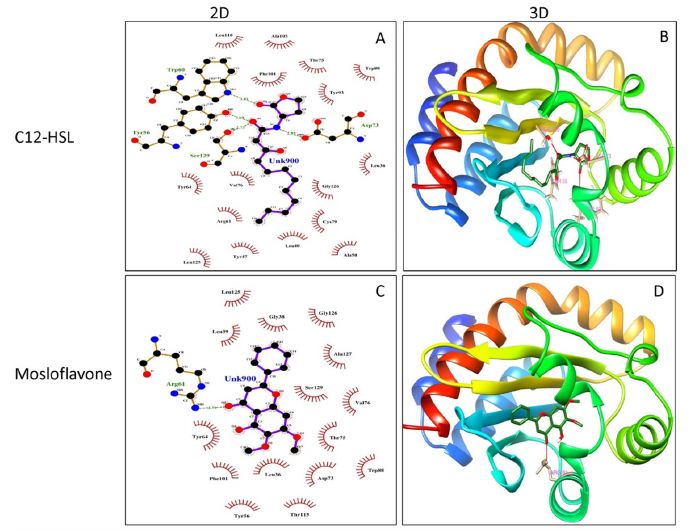
Fig. 5. Molecular docking studies of mosloflavone from crude extract of P. tenuiflorus to study the binding affinity with the active site of the receptor protein, LasR compared to the natural ligand (C12-HSL). (A) 2D docked conformation of C12-HSL (natural ligand) into the active site of LasR; (B) 3D docked conformation of C12-HSL into the active site of LasR, (C) 2D docked conformation of mosloflavone into the active site of LasR, (D) 3D docked conformation of mosloflavone into the active site of LasR.